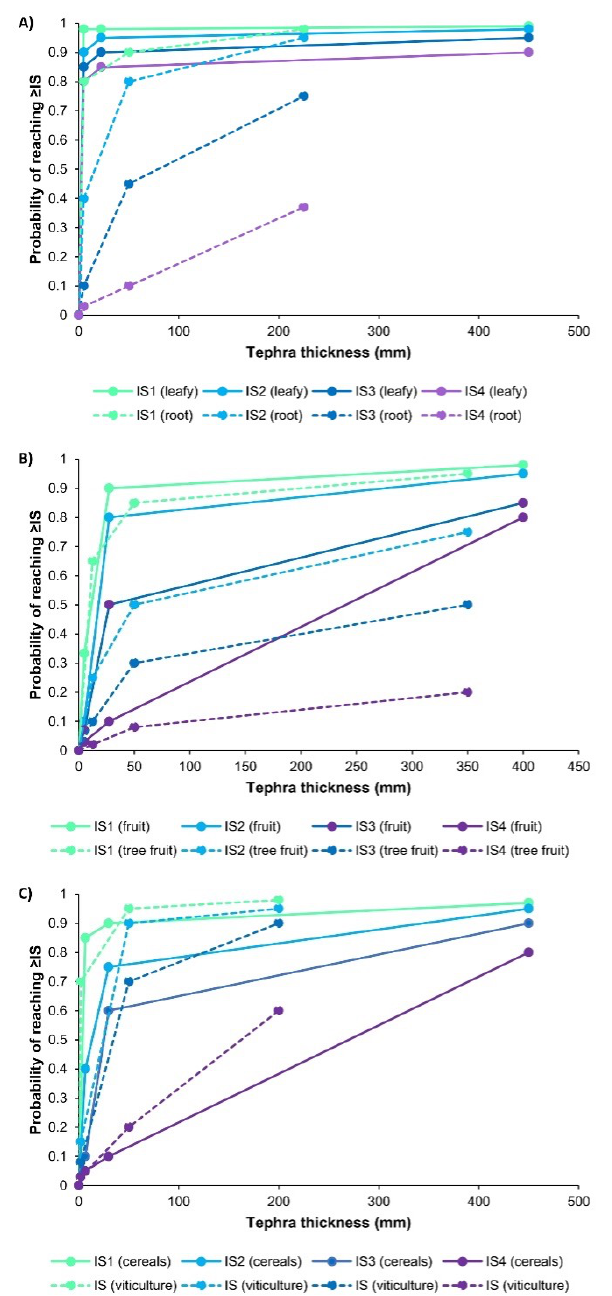
Figure 6: Horticultural crop fragility function suite for [A] root and leafy vegetables; [B] non-tree fruits and tree fruits; and [C] cereal and viticulture